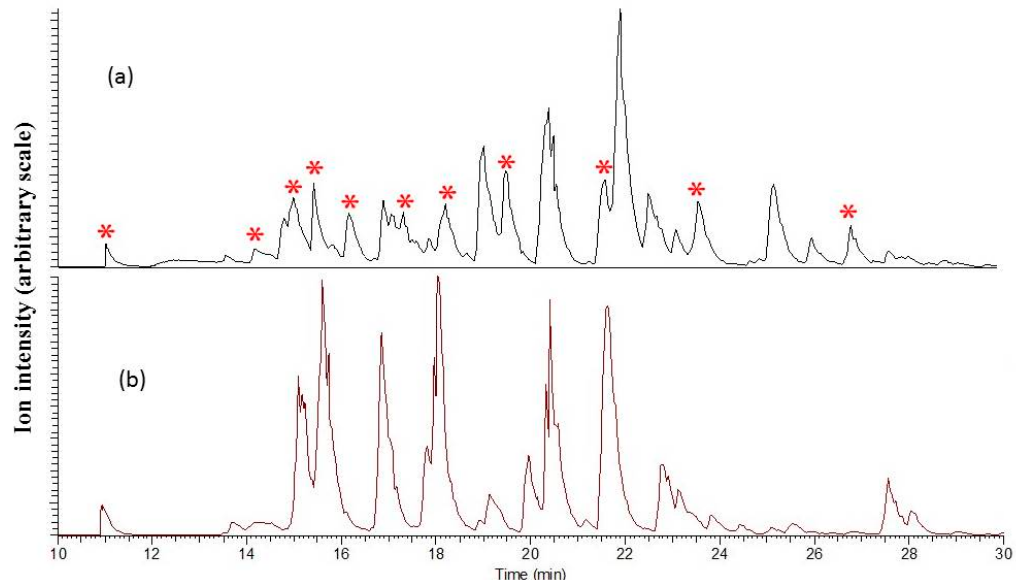
Figure 4. Base peak chromatogram of ( a ) the core fraction and ( b ) the non-core fraction. The star (*) indicates peaks belonging to peptides containing a non-oxidized cysteine residue. Non-labeled peaks belong to peptides containing no cysteine residue.